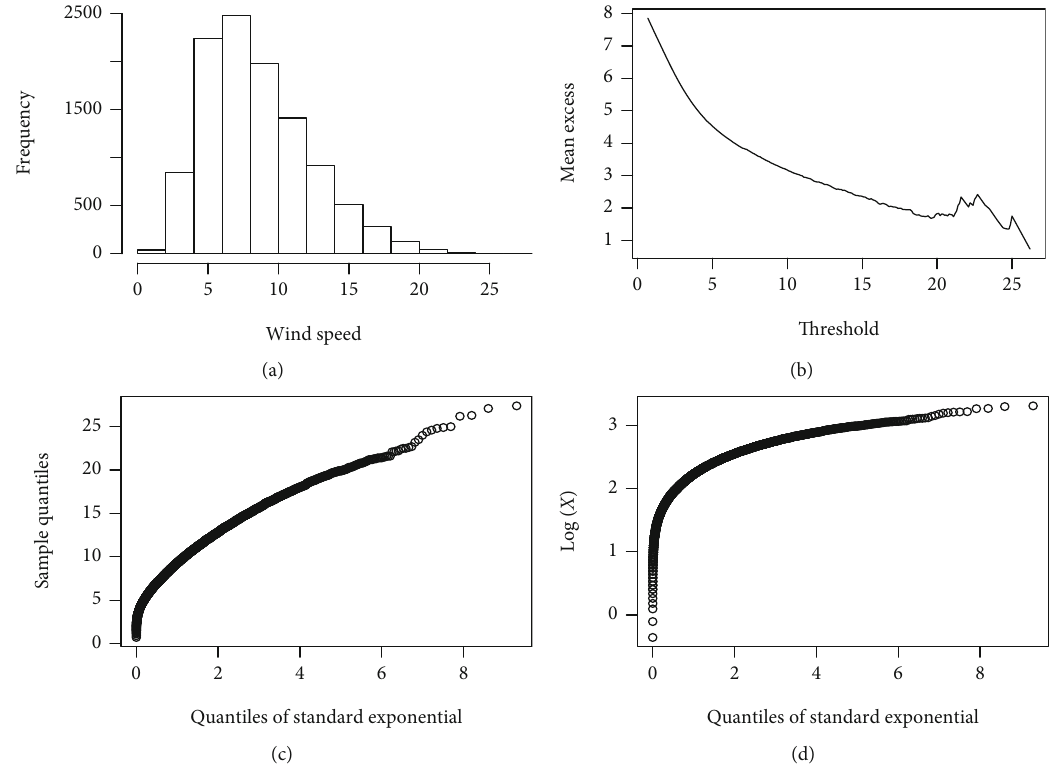
Figure 6: Preliminary analysis: (a) histogram, (b) mean excess plot, (c) exponential QQ-plot, and (d) Pareto